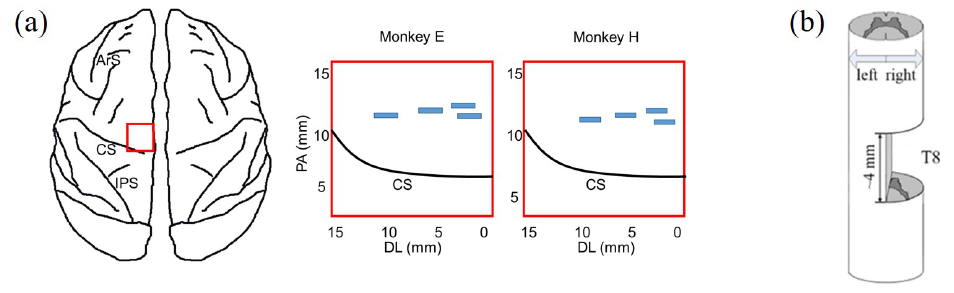
Figure 2. Locations of surgeries. ( a ) Cortical array implantation: Left, red rectangle indicates the location in the cortex—the rectangular area is close to the midline of the cortex (0 mm of the horizontal axis); Right, four blue rectangles indicate the locations of the 4 chronically implanted microelectrode arrays in monkey E and monkey H, respectively. Arcuate Sulcus: ArS; Central Sulcus: CS; Intraparietal Sulcus: IPS. ( b ) Spinal cord hemisection was at the right-hand side of T8 with 4 mm